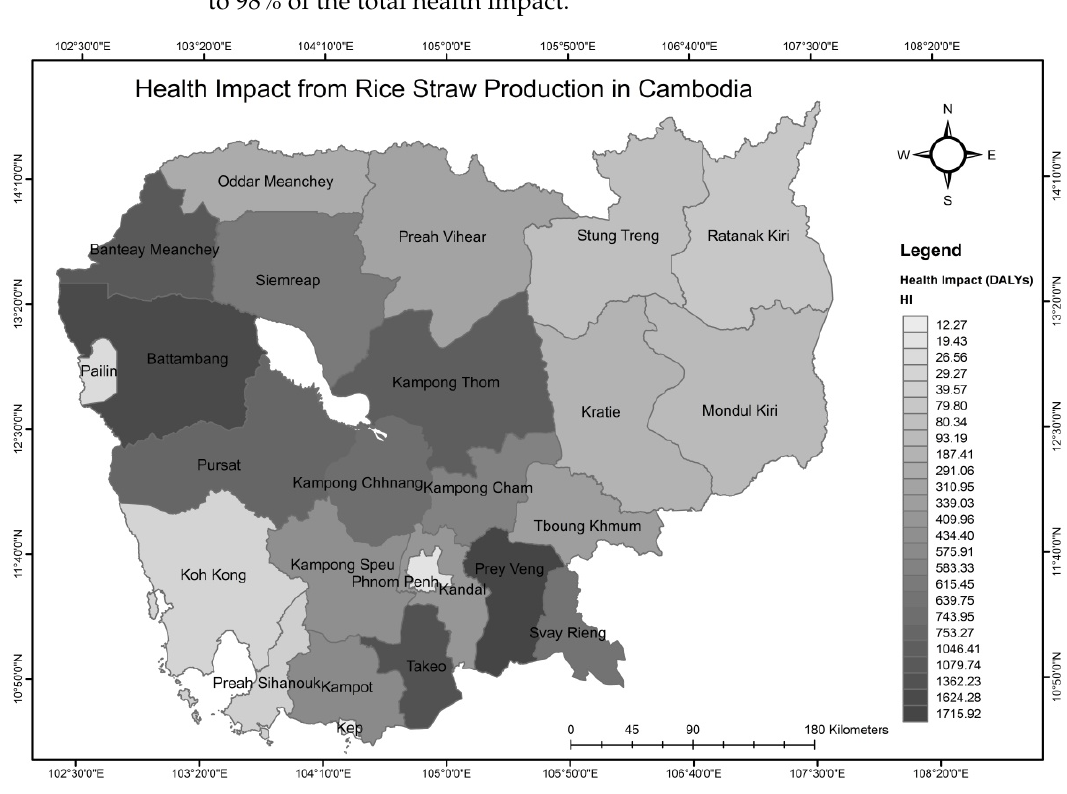
Figure 4. Health impact from rice straw production in Cambodia.